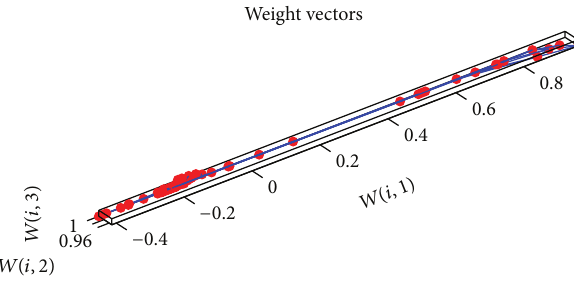
Figure 14: Training weights of SOM neural network optimized by improved PSO algorithm.